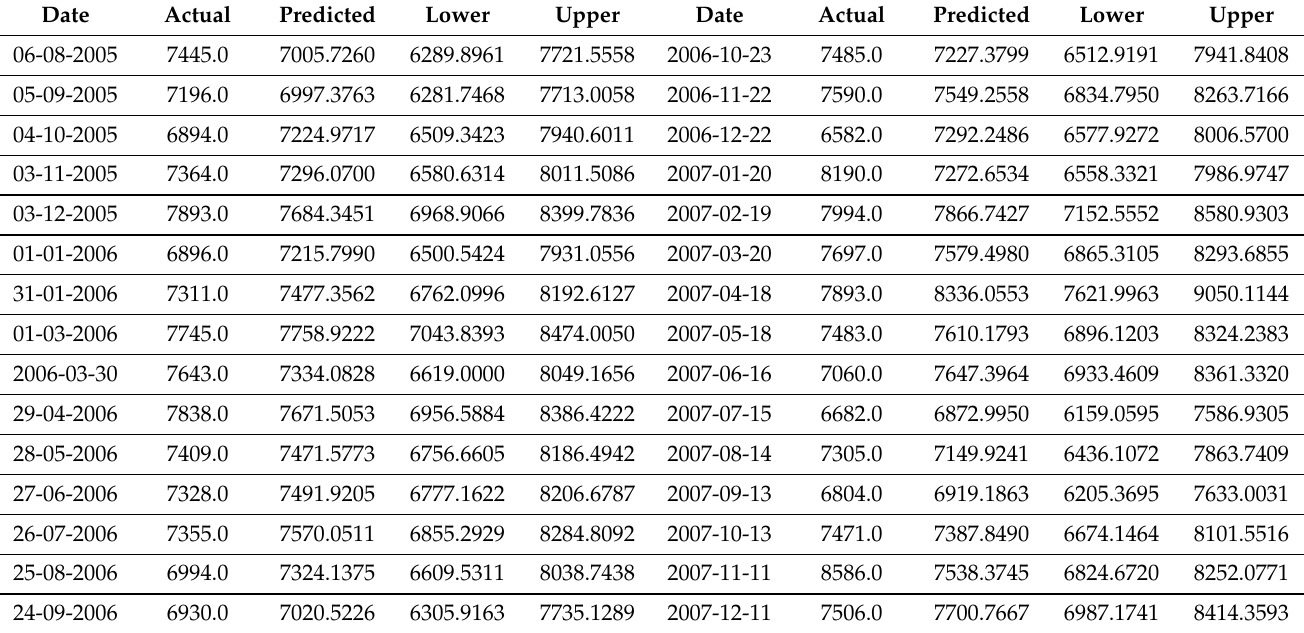
Table 4. Experimental results for the proposed SARIMA ( 1,0,2 ) × ( 1,0,0,3 ) model (from 6th of August 2005 until 11th of December 2007) with 95% CI.